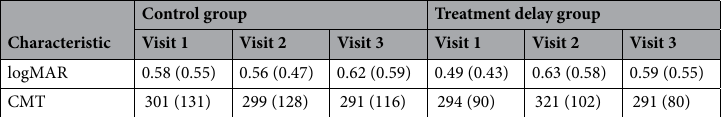
Table 2. Visual acuity and CMT for all visits. Values are presented as means with standard deviations.